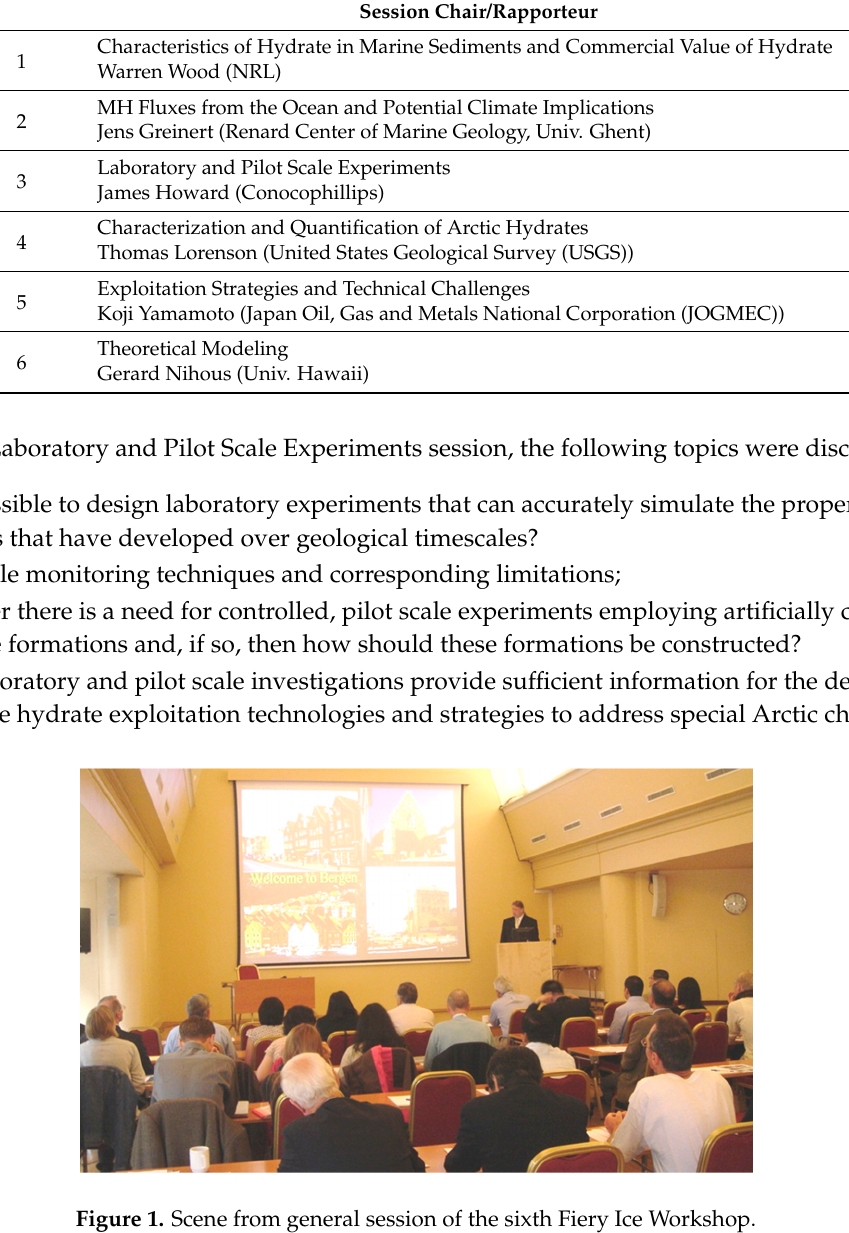
Table 7. Breakout sessions (title and chairs/rapporteur).